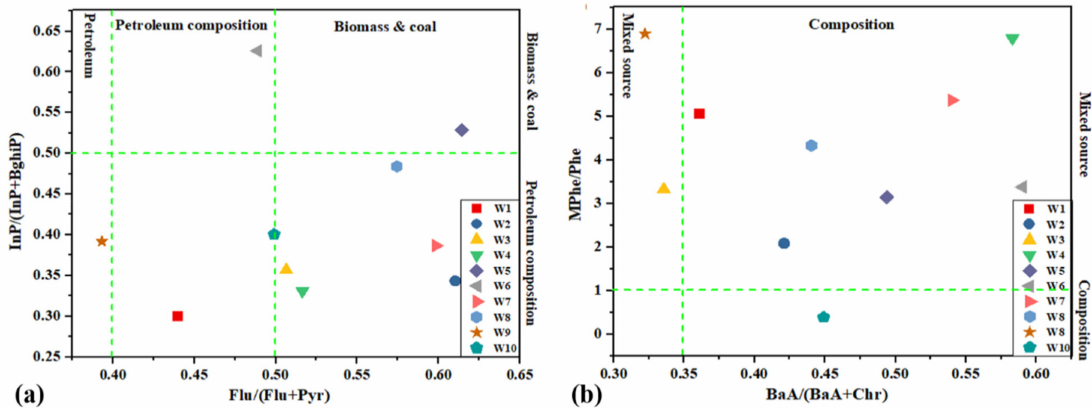
Figure 3. Plots showing PAHs and Me-PAHs isomeric ratios ( a ) Flu/(Flu+Pyr) vs. InP/(InP + BghiP) and ( b ) BaA/(BaA + Chr) vs.